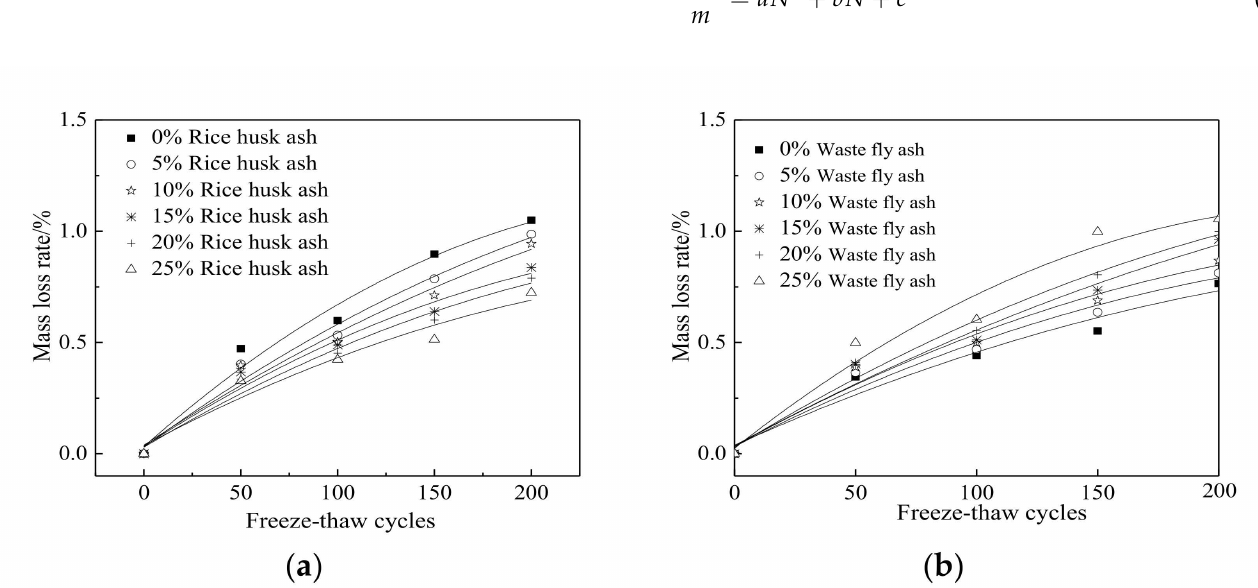
Figure 8. The mass loss rate of RPC during NaCl freeze–thaw cycles. ( a ) The mass loss of RPC with rice husk ash. ( b ) The mass loss of RPC with waste fly ash.